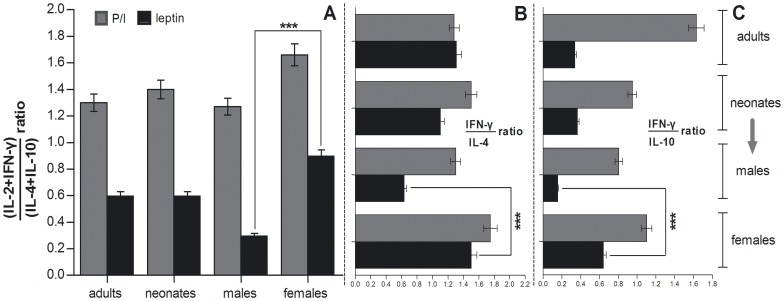
Cytokine gene expression ratios in 40 neonate CBMC (male and female) vs 20 adult PBMC cultured with P/I or rleptin.A, type-1 (IL-2+ IFN-γ) over type-2 (IL-4+ IL-10) gene expression ratios; B, Th1 (IFN-γ) over Th2 (IL-4) gene expression ratios; C, Th1 (IFN-γ) over IL-10 gene expression ratios. Results are given as mean ±%CV; asterisks indicate statistical significance (***, P<0.001, compared with 2-way ANOVA).